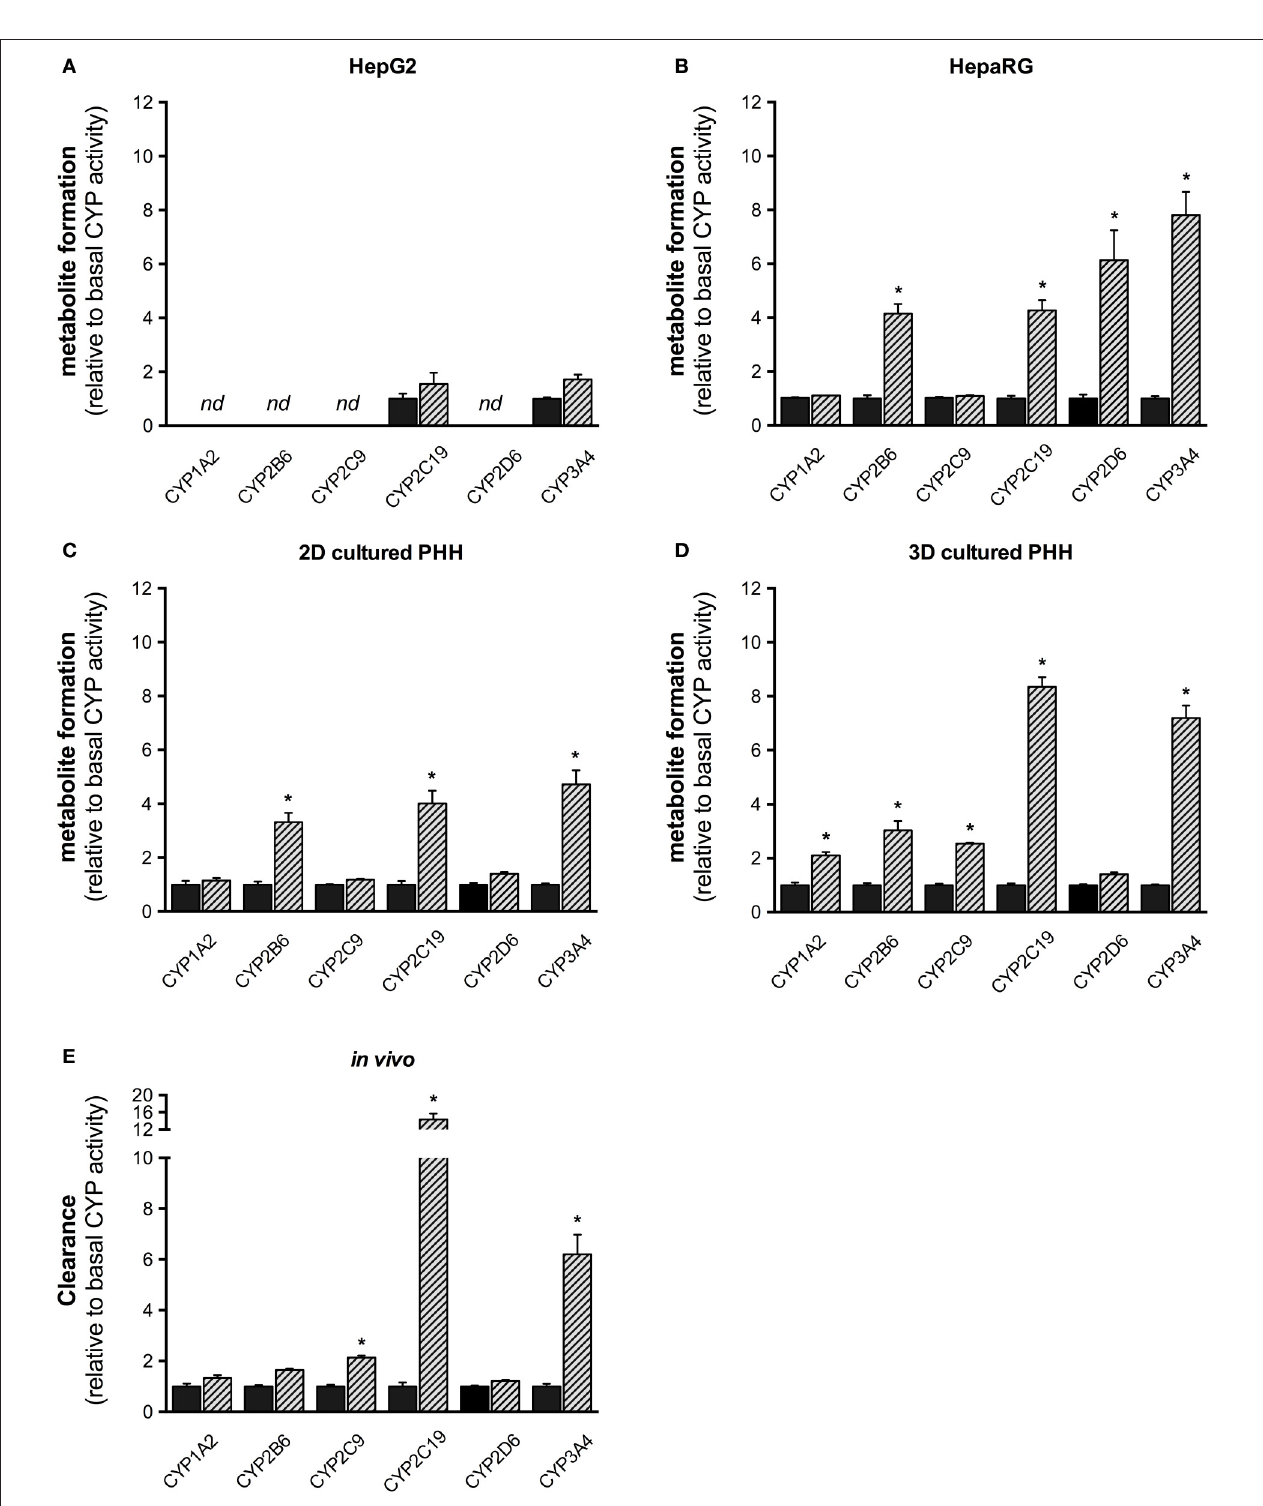
FIGURE 5 | Fold increase (relative to non-induced control) of CYP activity in vitro in HepG2 (A) , HepaRG (B) , 2D-, and 3D-cultured primary human hepatocytes (C,D) , and in vivo in healthy male subjects ( E , n = 14 for CYP2C19 and CYP2D6; n = 15 for all other CYP isoforms) after treatment with rifampicin. Hepatocyte cell lines were treated with 20 µ M rifampicin for 72 h and healthy volunteers with 600mg rifampicin per day for 7 days as described in the Materials and Methods Section. Metabolite and parent drug concentrations were determined by LC-MS/MS. Results are expressed as mean ± SEM. PHH, primary human hepatocytes. * p < 0.05 vs. control.